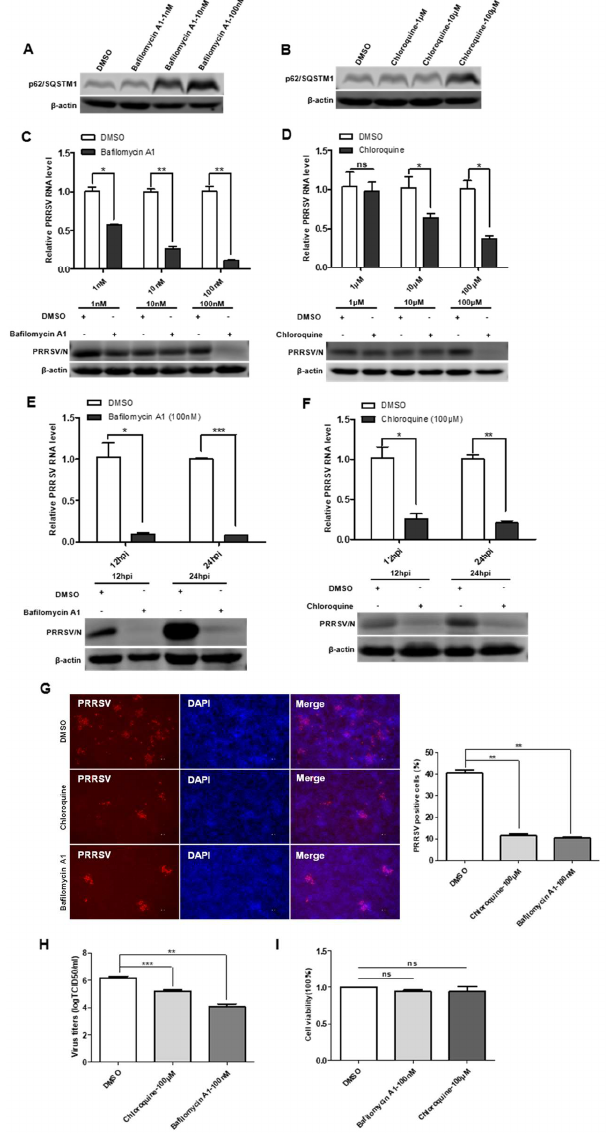
Figure 6. Autophagy inhibitors reduce PRRSV infection. ( A , B ) Bafilomycin A1 and chloroquine inhibit autophagosome degradation. Immortalized PAMs were pretreated with DMSO or inhibitors, Bafilomycin A1 and Chloroquine, at different concentrations for 24 h, and then harvested and lysed. Extracts were analyzed by Western blot using an anti-p62/SQSTM1 antibody. ( C – F ) Reduction of PRRSV RNA and N protein levels by autophagy inhibitors is dose- and time-dependent. Viral RNA in immortalized PAMs was determined by qPCR; The levels of viral N protein levels in immortalized PAMs were analyzed by Western blot. ( G ) Autophagy inhibitors decrease the number of PRRSV-positive cells. Immortalized PAMs were pretreated with DMSO or autophagy inhibitors, Bafilomycin A1 and Chloroquine, at different concentrations for 24 h. After washing, the cells were infected with PRRSV or mock control in the absence or presence of inhibitors. At 48 hpi, the cell monolayers were fixed and examined for PRRSV infection by IFA with an anti-PRRSV N protein mAb. The number of PRRSV- positive cells was calculated. ( H ) Virus titers were reduced after inhibitor treatment, as detected by the TCID50 assay. ( I ) Effects of inhibitors on cell proliferation. Immortalized PAMs were treated with the carrier control DMSO or autophagy inhibitors, Bafilomycin A1 and Chloroquine, at the indicated concentrations for 24 h. Cell cytotoxicity was analyzed with the CCK-8 system as described in Materials and Methods. Results are representative of three independent experiments (means ± SD). ns p > 0.05; * p < 0.05; ** p < 0.01; *** p < 0.001. The p -value was calculated using Student’s t